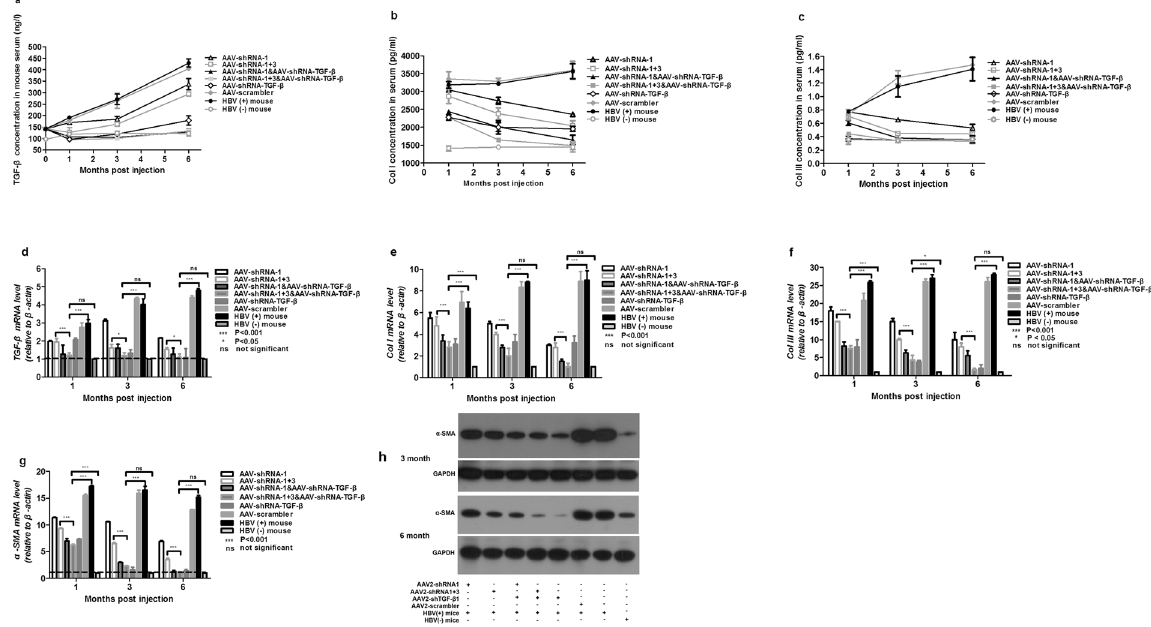
Figure 7. AAV-shRNA treatment decreases the expression of liver fibrosis biomarkers in HBV-persistent mice. Mice received AAV2-shRNA treatment, and serum levels of TGF- β ( a ), collagen I ( b ), and collagen III ( c ) were measured by ELISA during a 6 month period. ( d – g ) Reverse transcription quantitative PCR measurements of Tgf- β 1 ( d ), Col I ( e ), Col III ( f ), and α -SMA ( g ) mRNA levels in the liver. ( h ) Western blot analysis of α -SMA in liver samples. Statistical analyses were performed using a two-way analysis of variance. P < 0.05: significant difference. Ns: the difference was not significant. Data represent the mean ± SD (n =